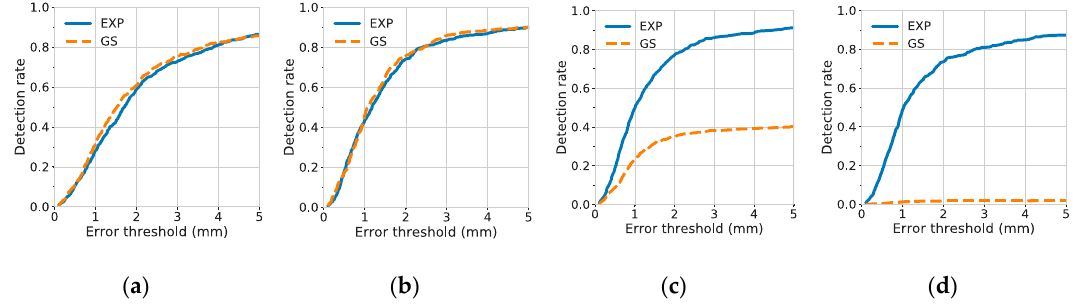
Figure 6. Detection rate of the C7 center against different degrees of error thresholds. The results of various σ values: ( a ) σ = 6.28; ( b ) σ = 3.14; ( c ) σ = 1.57; and ( d ) σ = 0.79. The detection rates were results from 10-fold cross-validation (mean with 1 standard error band). For each figure, EXP and GS stand for exponential and Gaussian heatmaps, respectively.